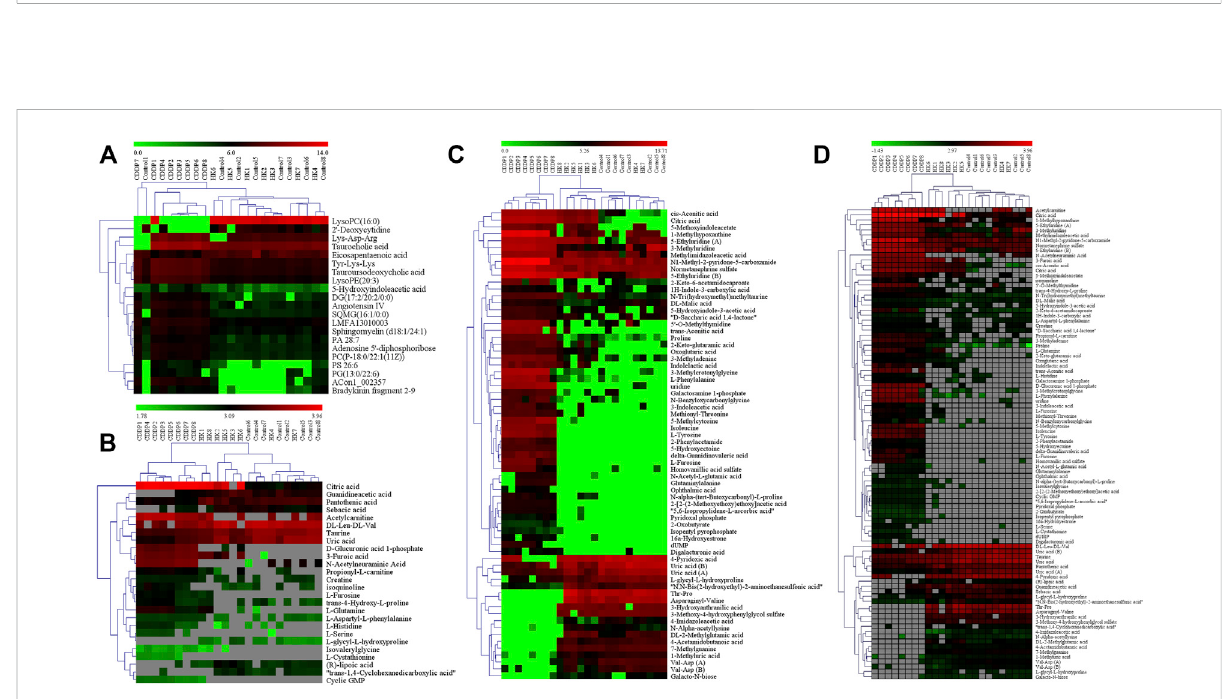
FIGURE 4 The heatmap andhierarchical clusteranalysisofrelativecontents ofpotential biomarkers. (A) Serum; (B) Urinefrom HILIC-Q-TOF/MS analysis; (C) Urine from RPLC-Q-TOF/MS analysis; (D) Kidney. The color demonstrated the clear up- or down-regulation of the PBs in 3 groups, while HCA analysis displayed the correlation of the samples (from the sample tree) and the identi fi ed PBs (from the gene